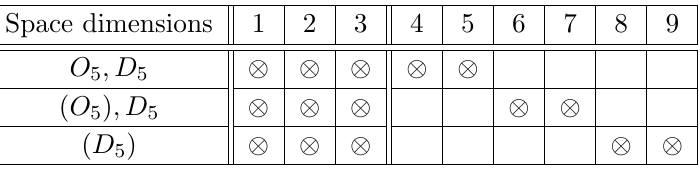
Table 1. O 5 =D 5 source con(cid:12)guration considered in this paper: they are along the three extended space dimensions, and some of the 6d ones. There is no overlap along the internal dimensions. Also, we do not allow for O 5 along all directions. Parentheses indicate that the presence of the source is